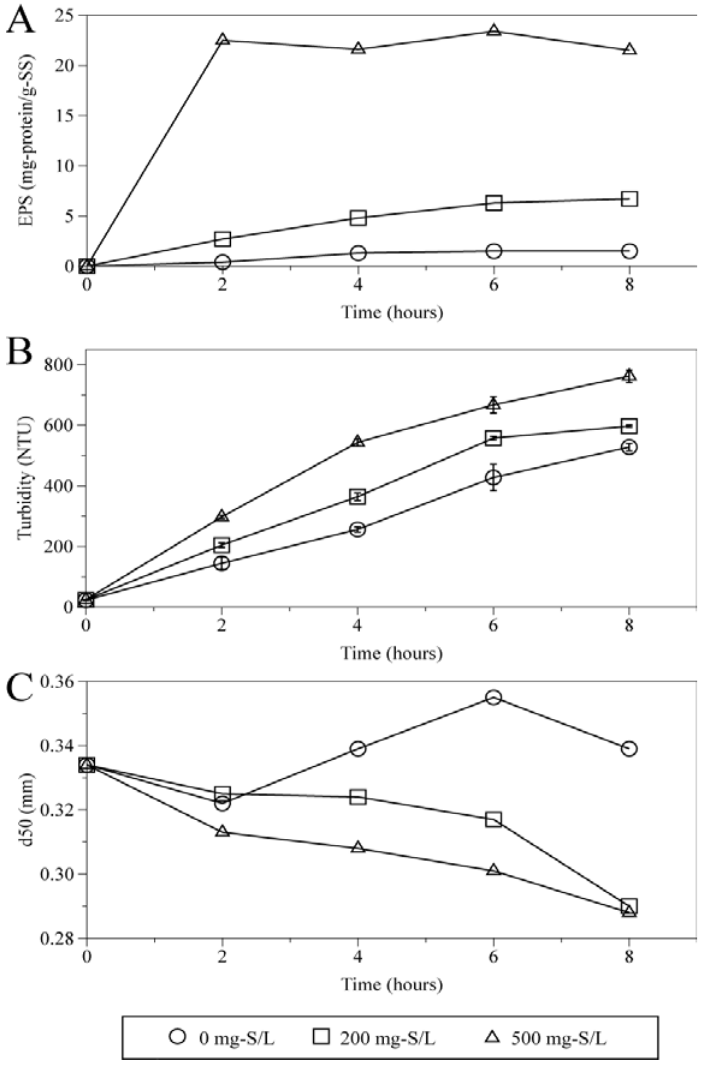
Figure 4. Time course of EPS protein released from the granules ( A ), turbidity ( B ) and median diameter of particles (>0.1 mm) ( C ) at different concentrations of